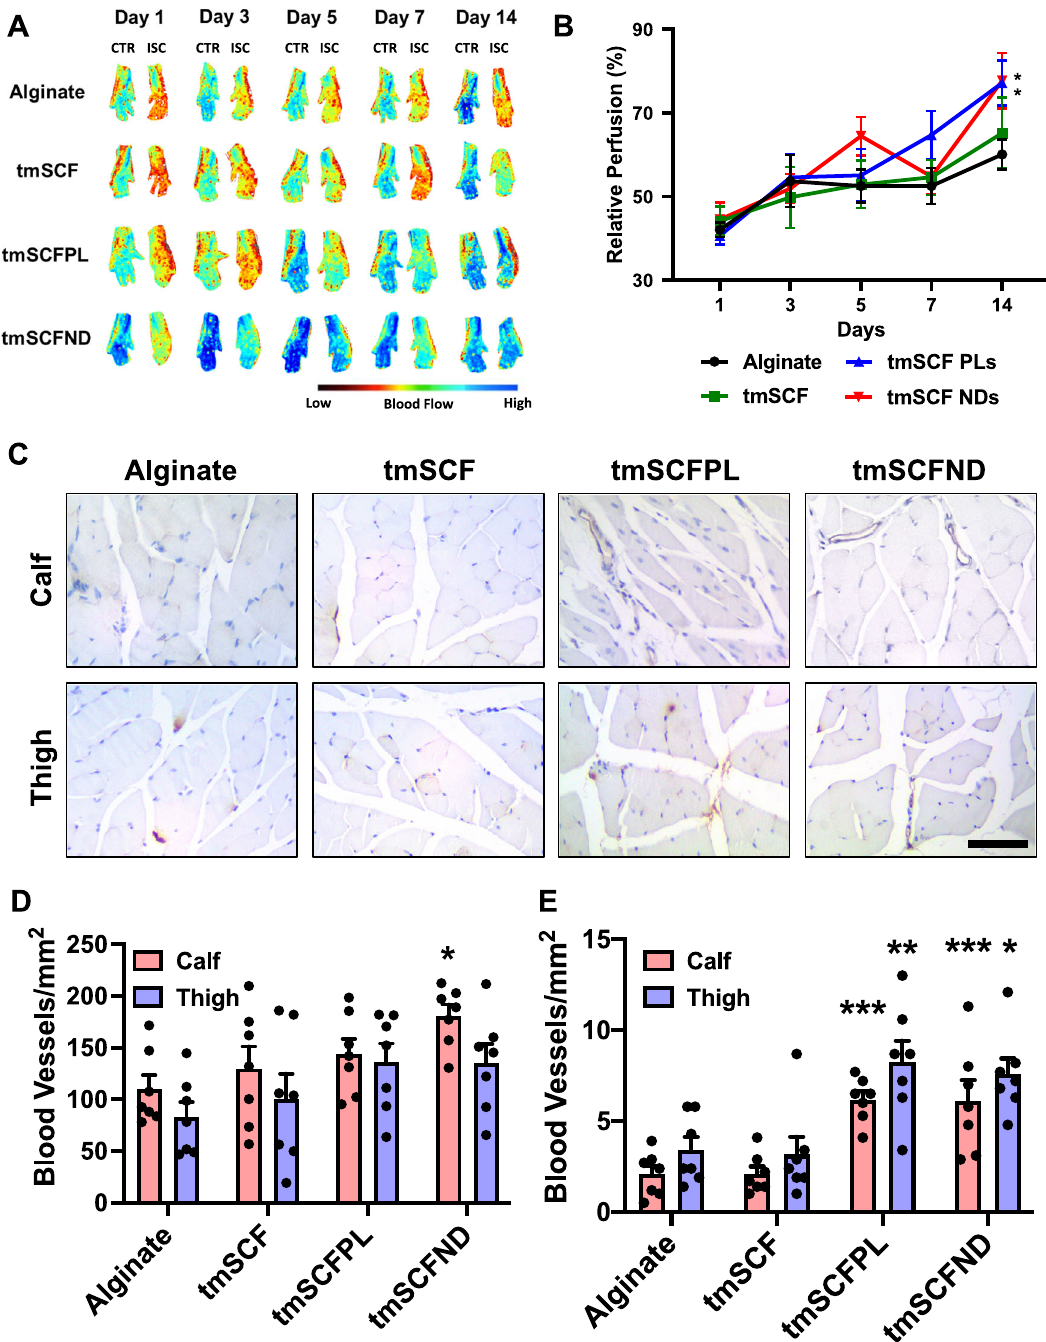
Fig. 4 Evaluation of treatments in a hindlimb ischemia model on ob/ob mice. A Representative mice foot images taken by laser speckle imaging. B Relative blood fl ow recovery after hind limb ischemia surgery on ob/ob mice ( n = 11 for tmSCF, 12 for other groups). p = 0.0424 on tmSCFPL vs control, and p = 0.0495 on tmSCFND vs control. Kruskal – Wallis test with Dunn ’ s post hoc was used. C Immunostaining for PECAM on mice on the muscles from the ischemic calf and thigh muscle of the mice after 14 days. Scale bar = 100 µ m. D Quanti fi cation small blood vessels in the calf and thigh muscle counted from PECAM immunostaining images ( n = 7). p = 0.0116 on tmSCFND vs alginate. E The number of large blood vessels in the tissues ( n = 7). p = 0.008 on tmSCFPL vs control and p = 0.009 on tmSCND vs control on calf muscle. p = 0.0035 on tmSCFPL vs control and p = 0.0122 on tmSCFND vs control on thigh muscle. Two-sided one-way ANOVA with Dunnett ’ s post hoc test was used. * indicates p value < 0.05, ** < 0.01, and *** <0.001. All the error bars are